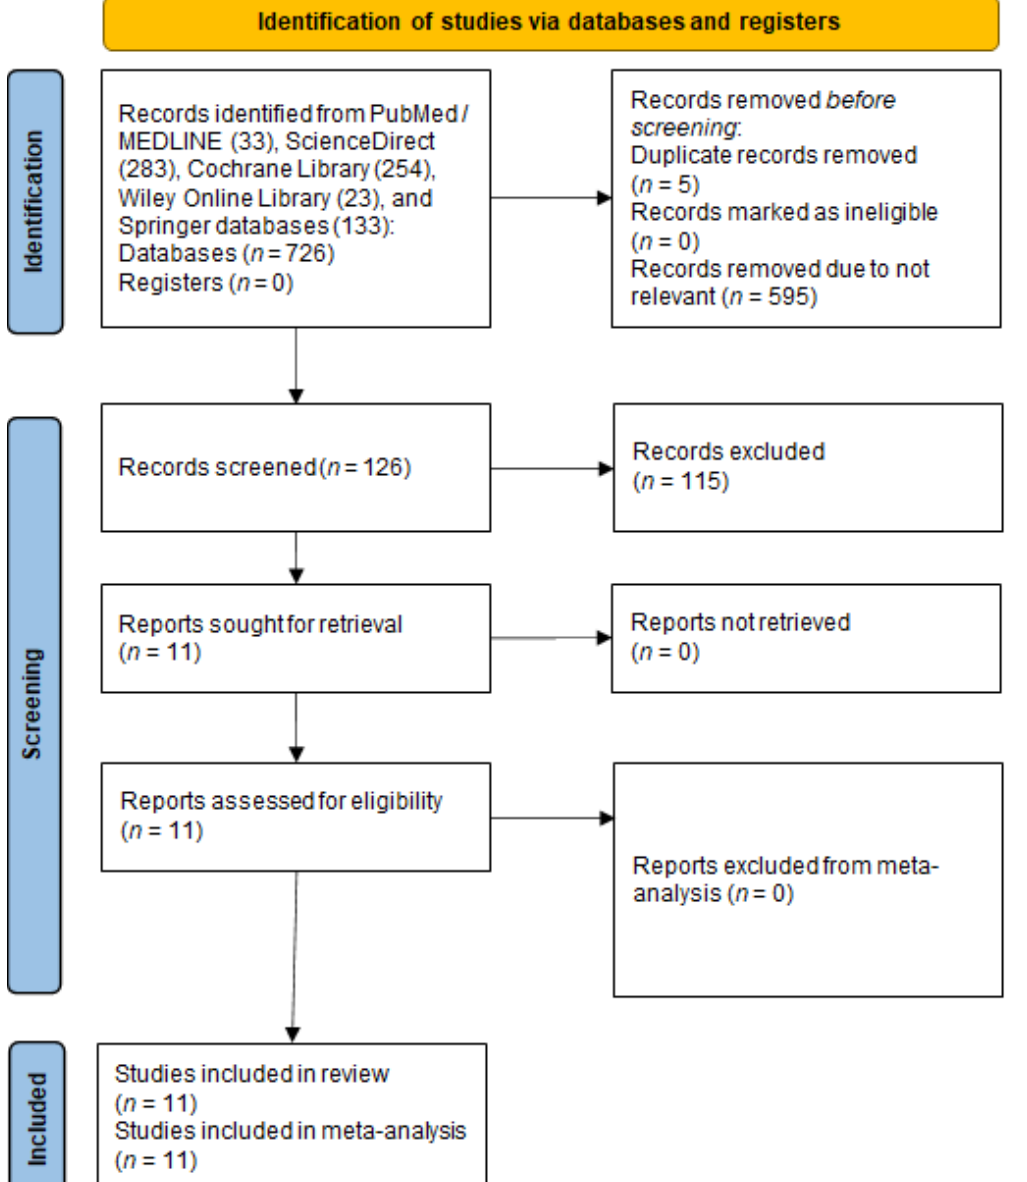
Figure 2. The PRISMA flow diagram of the literature search. From the 11 studies included in this review, there were 1,772,305 patients, consisting of 74,042 patients who underwent any form of bariatric surgery and 1,698,263 patients with no surgery. Reported bariatric procedures included Roux-en-Y gastric bypass, gastric banding, sleeve gastrectomy, biliopancreatic diversion, vertical banded gastroplasty and duodenal switch. The follow-up period of the studies ranged from 3 to 9 years. The detailed study characteristics are summarized in Table 1. Pooled means of the age of the study population were 52.55 years in the bariatric surgery group and 54.09 years in the no-surgery group. Pooled means of the BMI were 42.62 in the bariatric surgery group and 44.59 in the no-surgery group. The study population characteristics and comorbidities are listed and summarized in Table